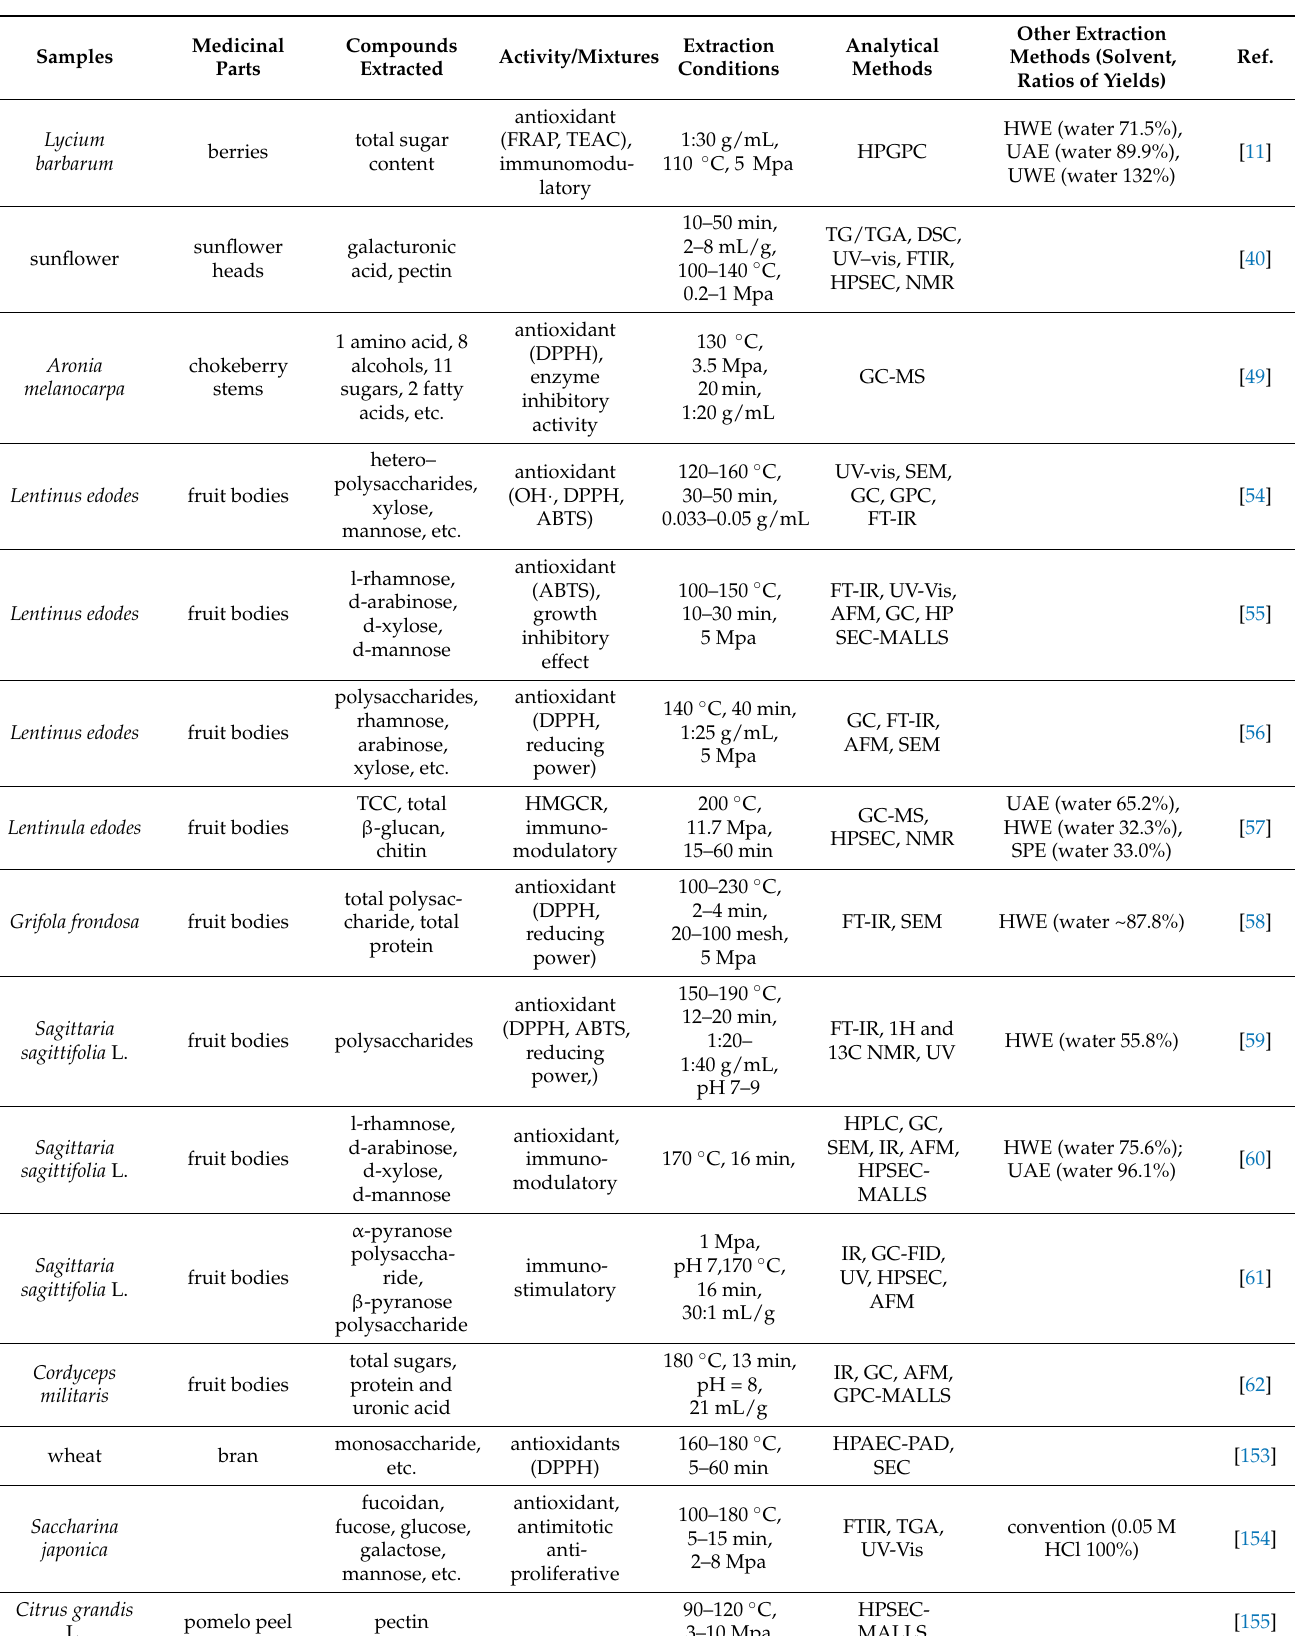
Table 5. Subcritical water extraction of